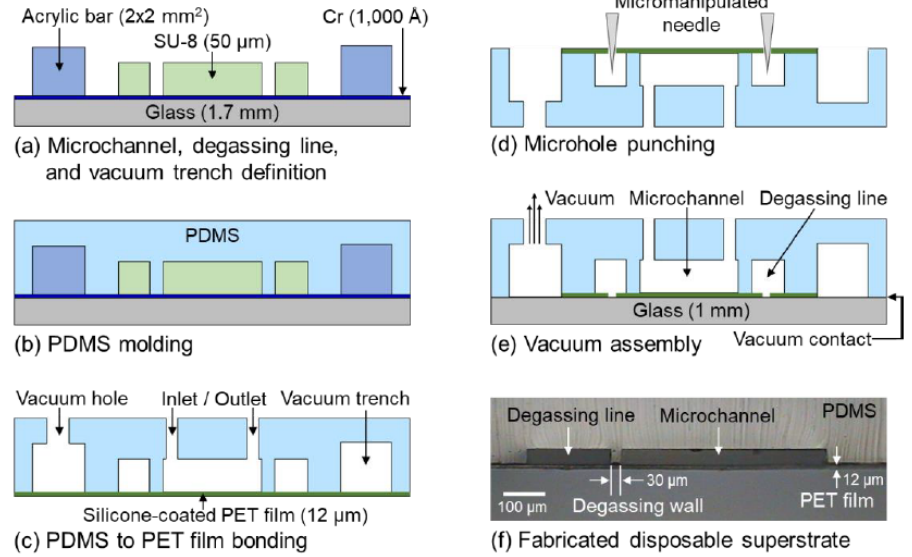
Figure 2. Fabrication process of the disposable microchannel superstrate with the lateral degassing method. ( a ) Cr deposition on a glass slide, followed by SU-8 patterning to define the microchannel and the degassing lines, and adhesive bonding of acrylic square bars to define the vacuum trench. ( b ) PDMS molding to create the microstructured PDMS replica. ( c ) Formation of inlet/outlet reser- voirs and vacuum hole and bonding of the PDMS replica with the silicone-coated release PET film. ( d ) Creation of the microholes. ( e ) Vacuum assembly of the disposable microchannel superstrate and the glass substrate to produce the disposable film-chip microfluidic device. ( f ) A cross-sectional view of the fabricated disposable microchannel